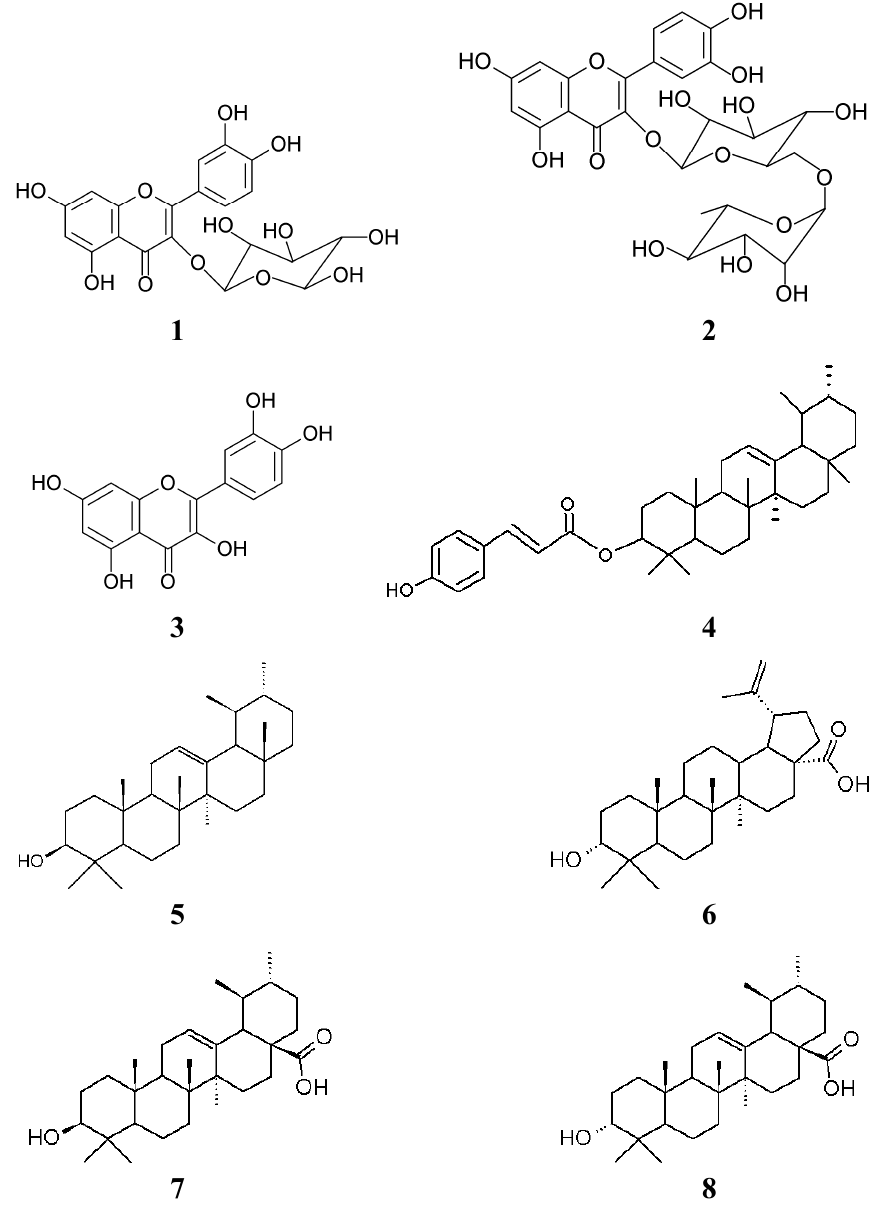
Figure 3. Isolated substances from M.